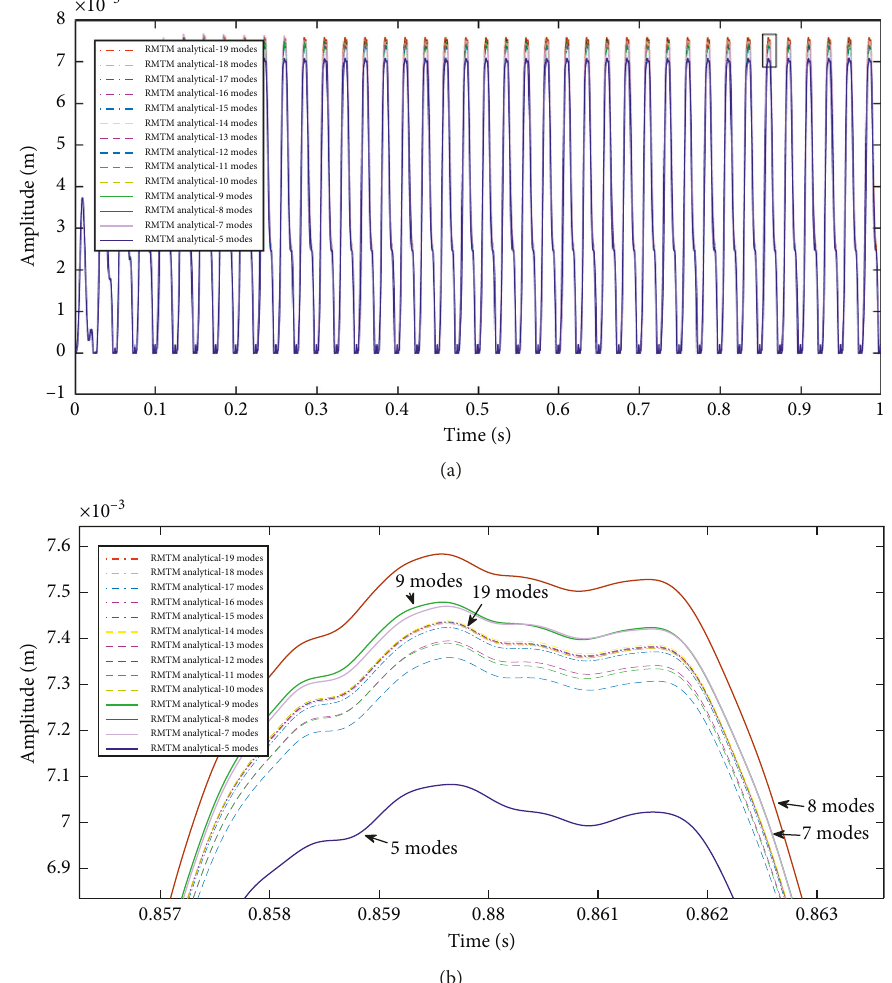
Figure 10: RMTM analytical time-history response: ω � 80 Hz, ξ � 0 . 02, and step � 1 × 10 − 5 . (a) Time-history. (b) Local amplification of the rectangle in